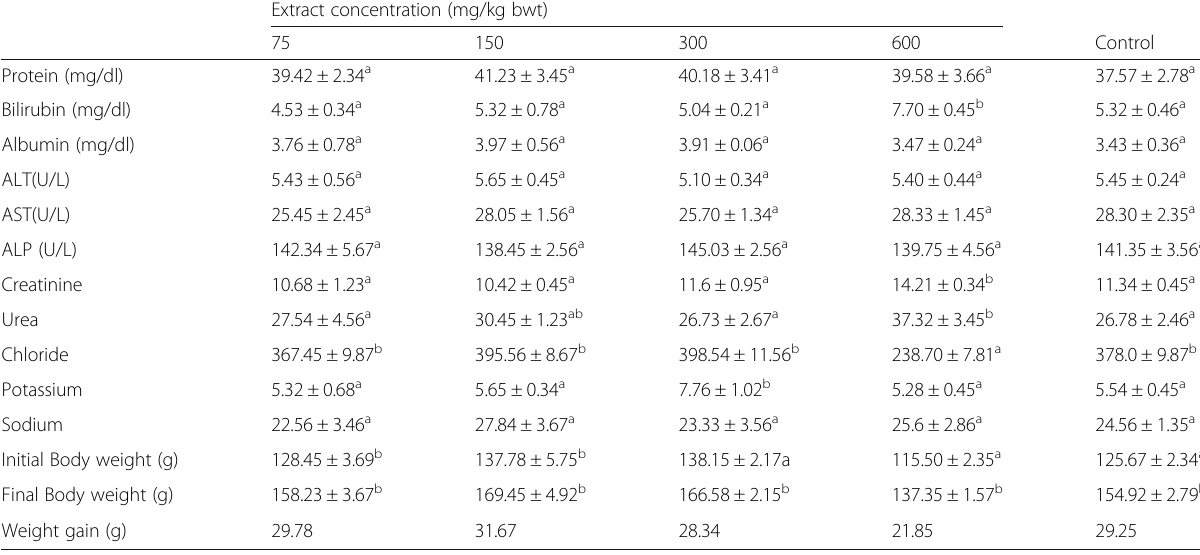
Table 8 Effects of methanol extract of Zingiber officinale on serum biochemical parameters and body weight gain in rats